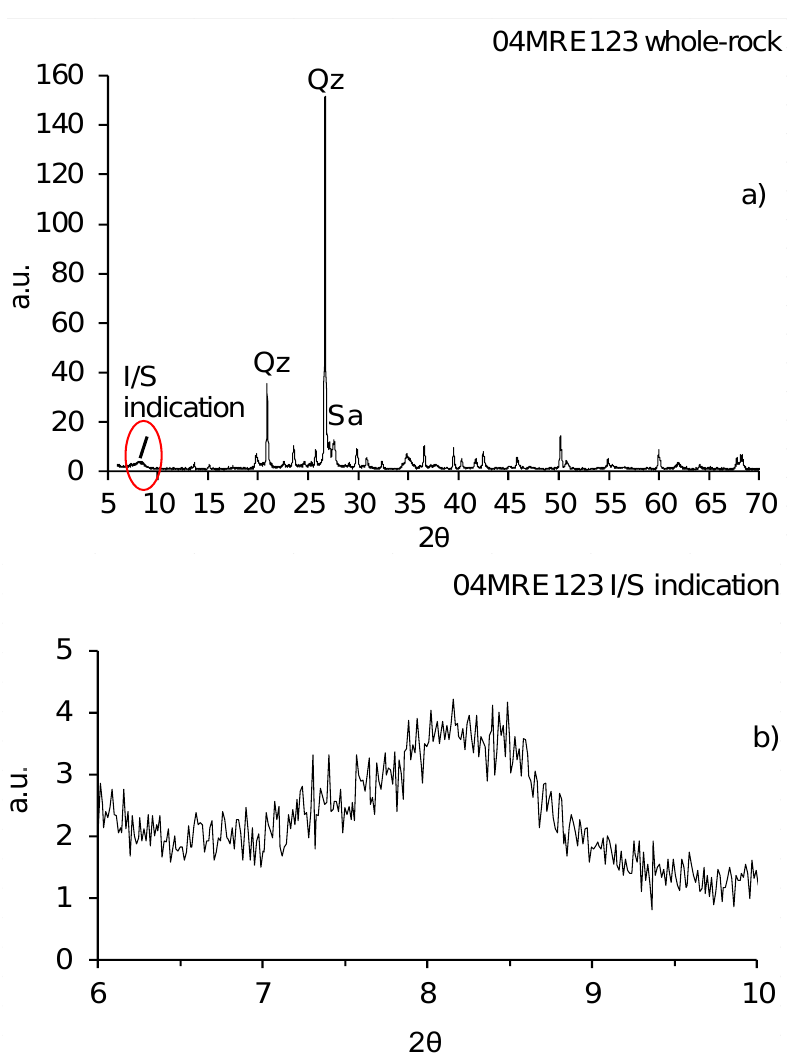
Figure 4. ( a ) Whole-rock X-ray diffraction pattern of the sample 04MRE123 from Rodalquilar. The pattern shows a sharp quartz peak at 26.5 °2θ and a sanidine peak at 28° 2θ. The peak at 8.4° 2θ indicate the interlayering of illite and smectite. ( b ) Zoomed-in section of the whole-rock X-ray diffraction pattern where the peak position of the I/S indication is shown.